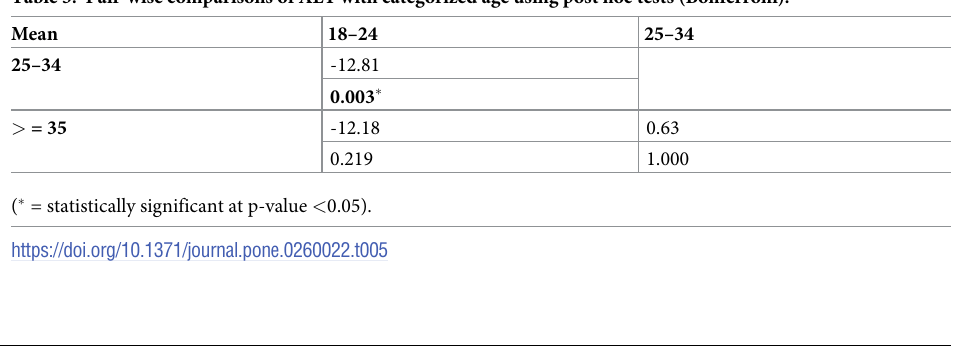
Table 5. Pair-wise comparisons of ALT with categorized age using post hoc tests